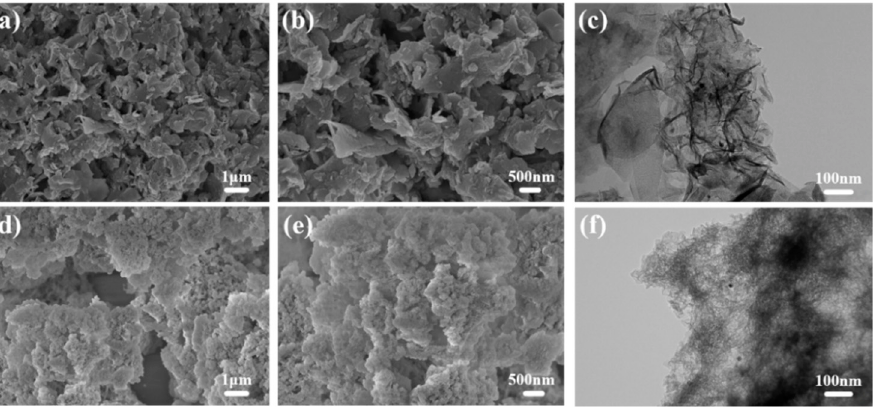
Figure 2. ( a , b ) FE-SEM images and ( c ) HR-TEM image of LDH; ( d , e ) FE-SEM images and ( f ) HR-TEM image of GA-LDH.